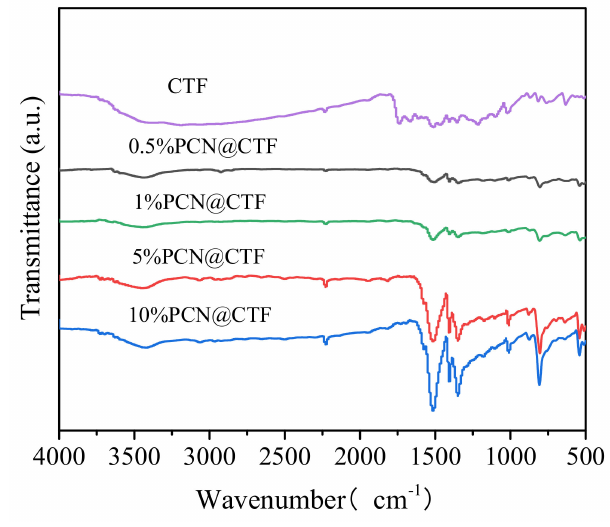
Figure 3. FTIR spectra of CTF and x %PCN@CTF.